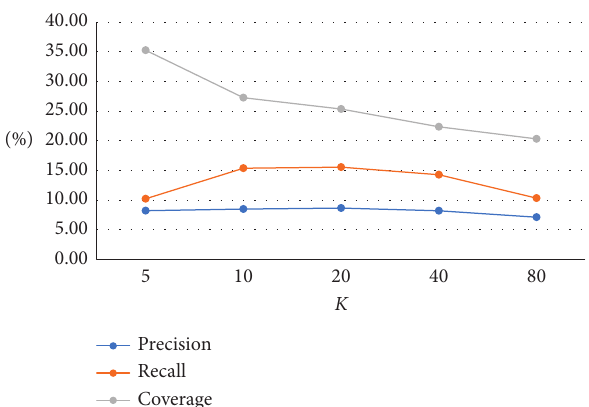
Figure 8: Based on cosine similarity, user similarity calculation is performed under multiple K values.